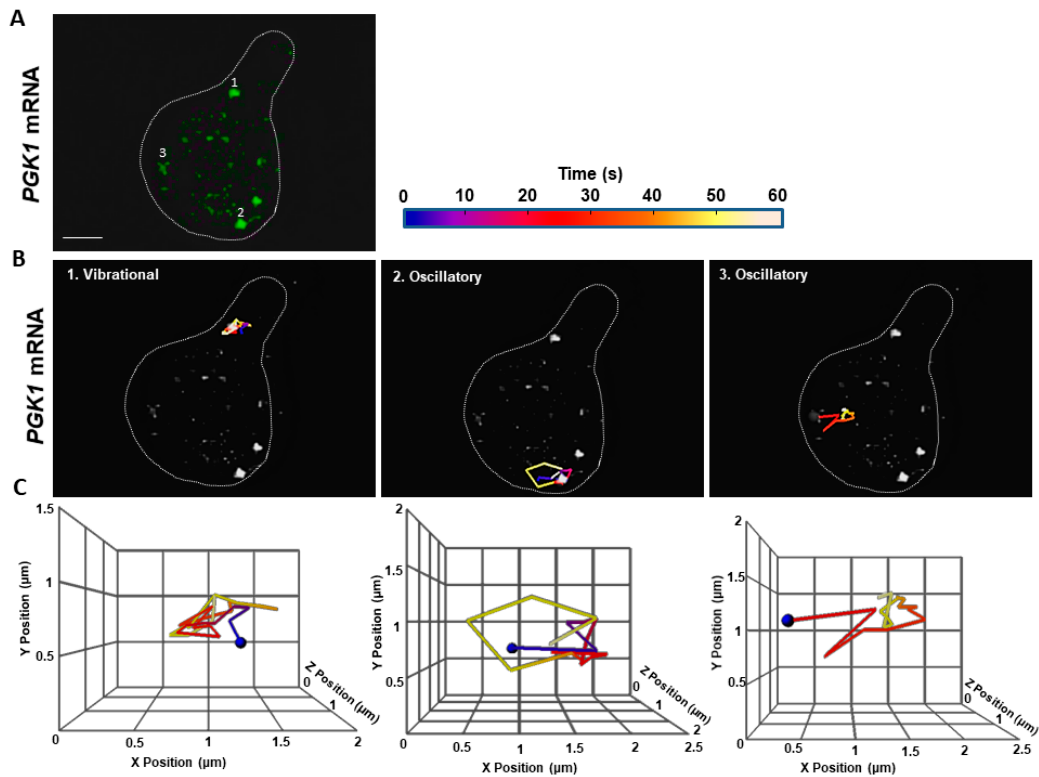
Figure 2. Only vibrational and oscillatory motions occurred in PGK1 granules in 3D. The explanation is similar to that for Figure 1, except that this cell expressed U1A-GFP labeled PGK1 mRNA. PGK1 granules did not exhibit translocational movement. Scale bar = 2 µm.